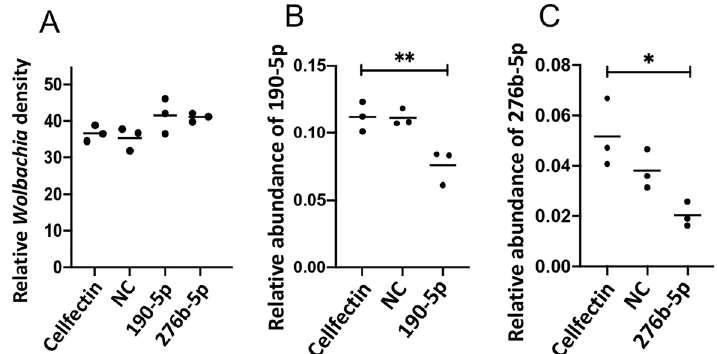
Figure 7. w AlbB density in miRNA inhibited Aag2. w AlbB cells. ( A ) w AlbB density of Aag2. w AlbB cells following transfection with specific miRNA inhibitors, random negative control (NC) or Cellfectin only. ( B ) and ( C ) Validation of inhibition of miR-190-5p and miR-276b-5p by RT-qPCR in the samples used in ( A ). Cross- bars represent the mean of three replicates. Asterisks indicate the level of statistical significance determined using to ANOVA. * p < 0.05; ** p <